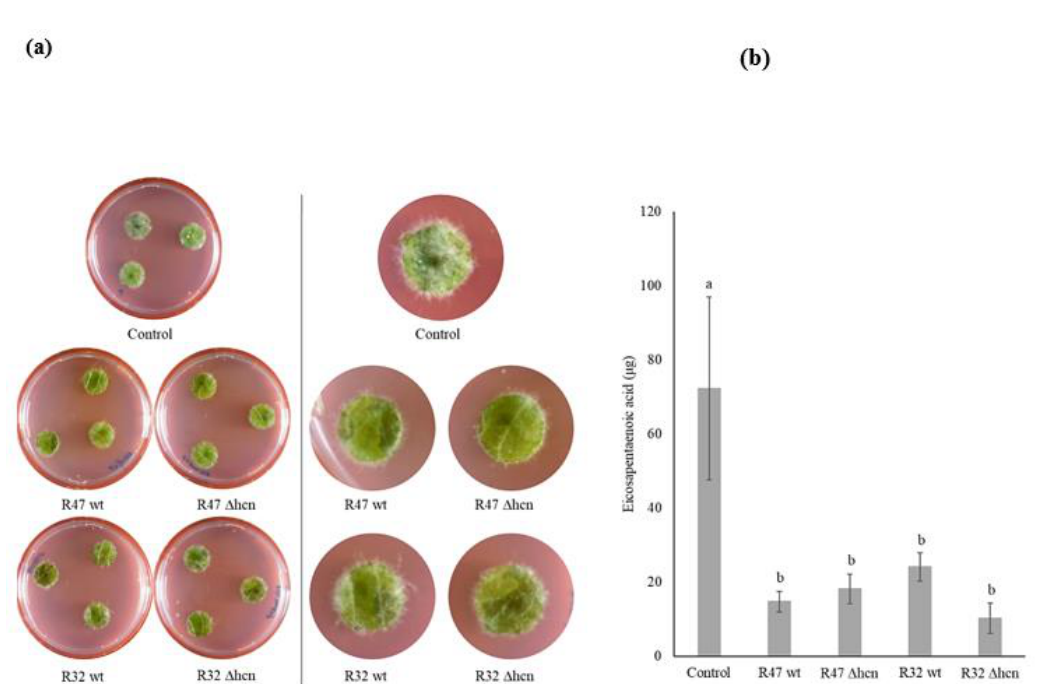
Figure 3. Pseudomonas strains (R32 and R47) restrict the infection by P. infestans on leaf disks. ( a ) Left panel: representative images of leaf disks co-inoculated with Pseudomonas strains and P. infestans zoospores. Pictures were taken 6 days post-inoculation. Right panel: zoomed images of leaf disks showing P. infestans infection (white hyphal mat). ( b ) Quantification of infection by measuring P. infestans -specific fatty acid (EPA; C20:5) content in leaf tissues. The bars show averages ( n = 3) with error bars indicating standard error of the mean. Letters indicate significant differences between treatments as per ANOVA followed by Tukey’s HSD (threshold p < 0.05).